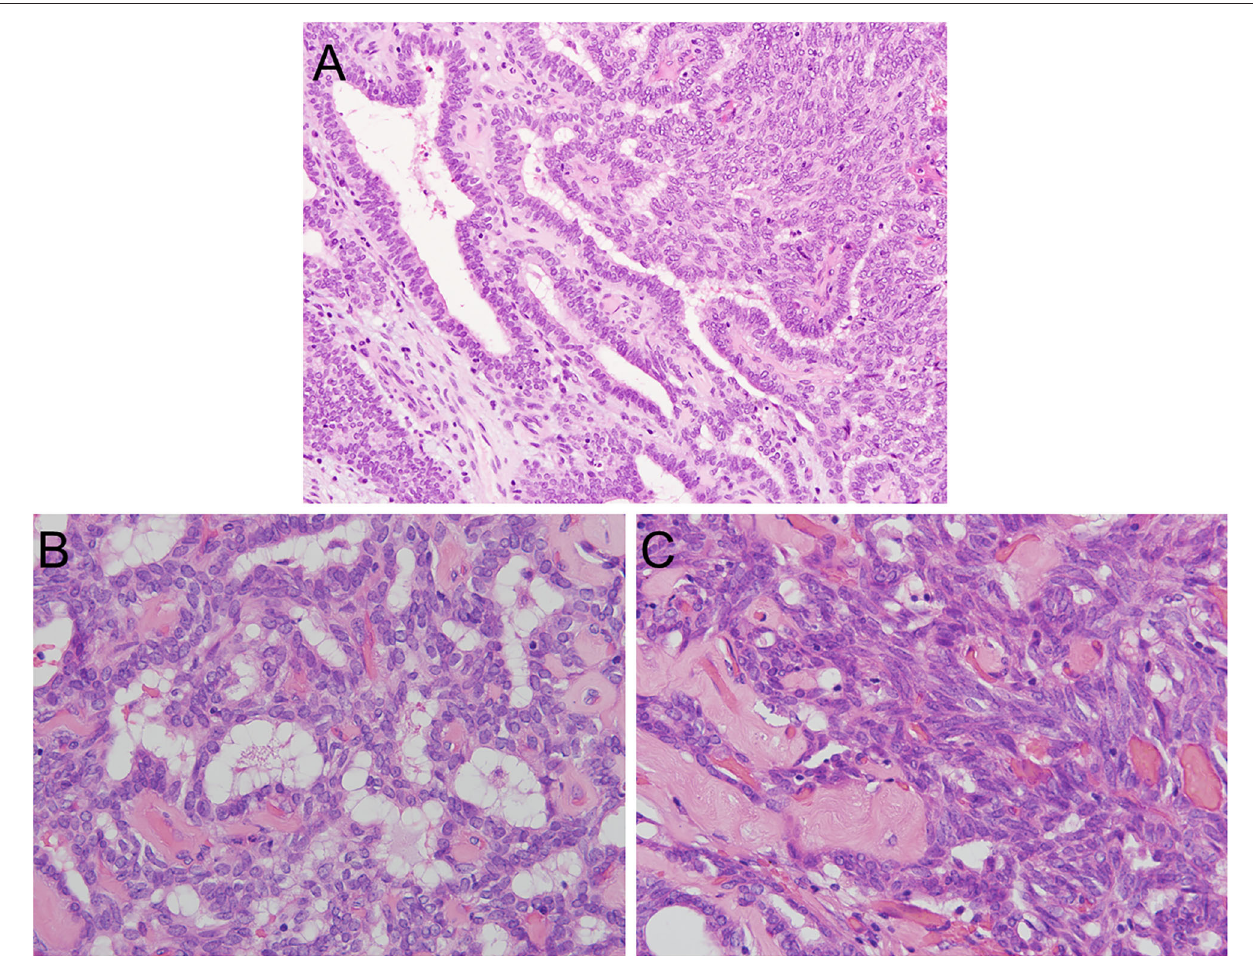
FIGURE 2 | Histopathological features of TL-LGNPPA. (A) Histological examination revealed a papillary structure with fibrovascular cores lined by cuboidal to columnar stratified cells with round to oval vesicular nuclei and eosinophilic cytoplasm. Psammoma bodies were not seen. The tumor showed invasive growth into the underlying fibrous connective tissue. (H&E staining, × 20). (B) An increase in nuclear chromatin and mild nuclear atypia were found, but no nuclear polymorphism was detected. Some cells had clear chromatin; however, the nuclear groove and nuclear pseudoinclusion were absent. No mitotic figures were found, and necrosis